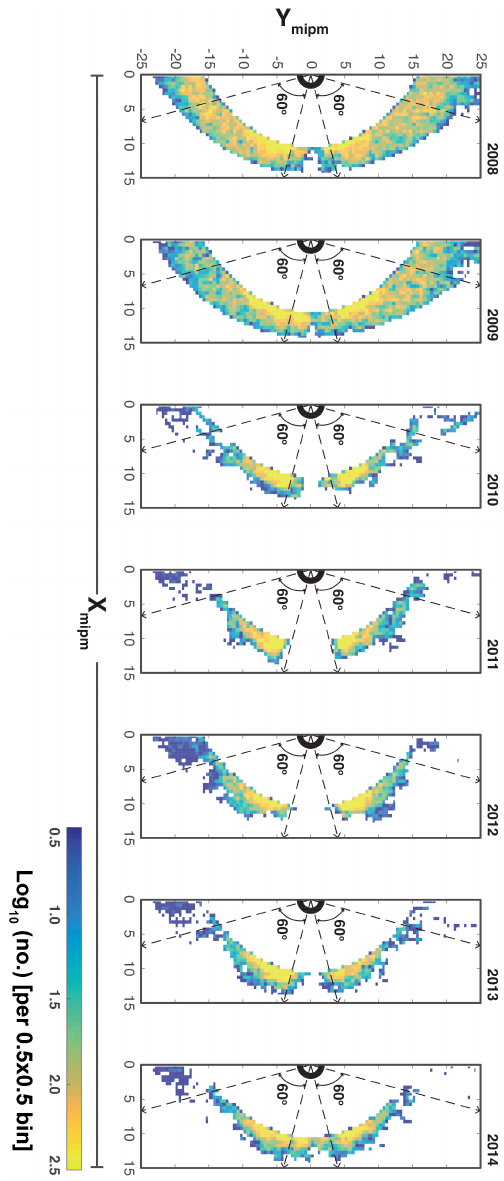
Figure A1. The annual data coverage of the THEMIS probes in the MIPM frame between 2008 and 2014. The colour in each statis- tical map corresponds to the number of points within each 0.5 R E square bin. Please note, these data are plotted in a base 10 loga- rithmic scale. As discussed in the main body of the manuscript, the 60 ◦ angular sector in which the data were used are indicated in each